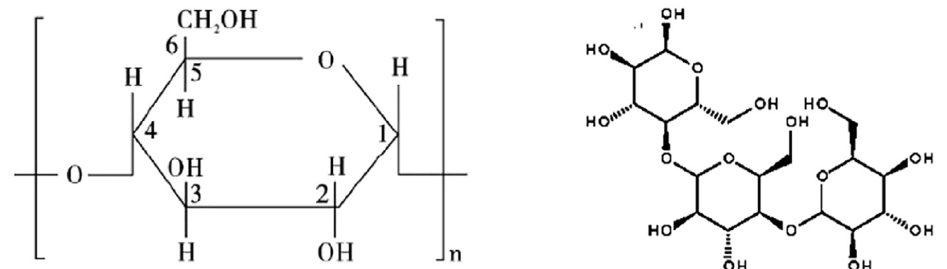
Starch and dextrin are a kind of macromolecular organic compound with the advan- tages of a comprehensive source, low cost, and strong depression effects on calcite [73,99]. The adsorption mechanism indicated that the -OH group of starch/dextrin as shown in Figure 10 [1], might adsorb on Ca sites at the surface of calcite through chemical bonds. The inner electron binding energy of Ca 2+ in fluorite is larger than the inner electron binding energy of Ca 2+ in calcite, which makes it more difficult to form chemical bonds. Therefore, the chemical adsorption of starch/dextrin on the surface of calcite is stronger than that on the surface of fluorite.